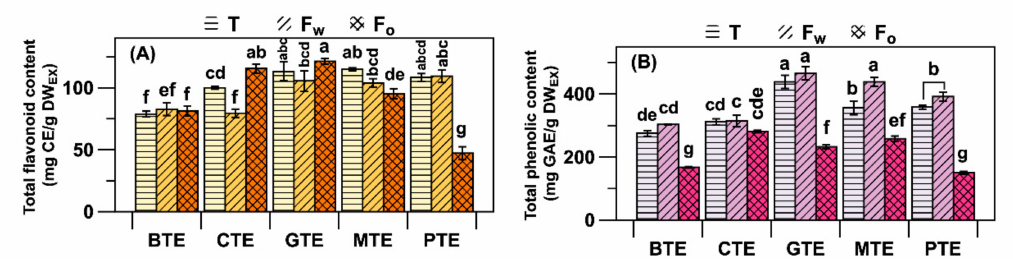
Figure 3. Contents of ( A ) total flavonoids and ( B ) total phenolics of five tea extracts and their fractions. Labels T, Fw, and Fo on top of the graphs indicate whole extract, W FR , and O FR , respectively. Lowercase letters on the bars indicate significant di ff erences according to the Tukey–Kramer honestly significant di ff erence test ( p < 0.05). CE, catechin equivalents; and GAE, gallic acid equivalents.